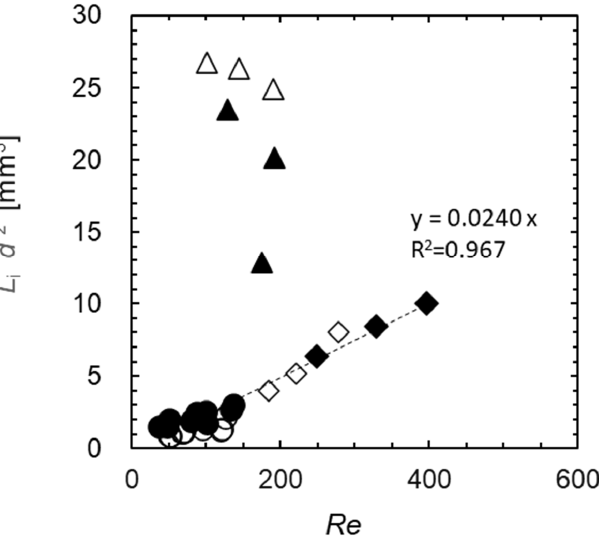
(cid:4) and • 1 mm; and 2 mm; (cid:52) and (cid:78) 3 mm; open: (cid:35) (cid:51)